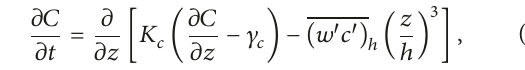
variables. The vertical diffusion of a variable 𝐶 can be written